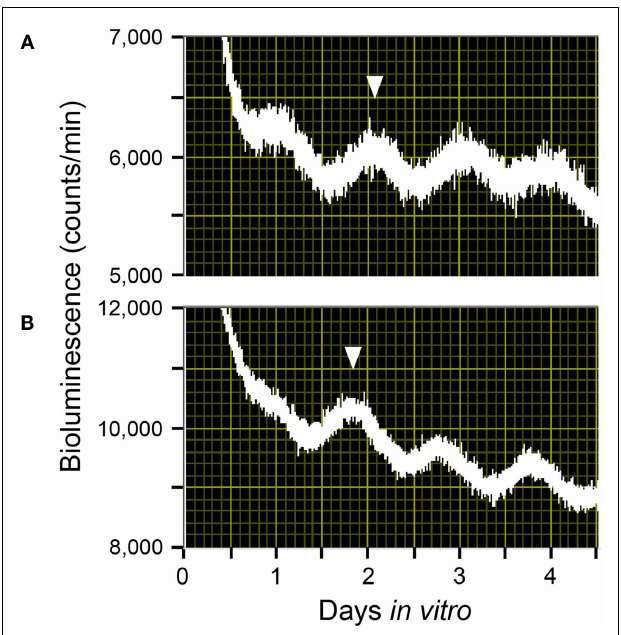
FIGURE 2 | Rhythms of light emission by fetal SCN explants . Shown are raw data from (A) a fetus of an ad lib-fed control Per1::Luc pregnant rat and (B) a fetus of a Per1::Luc pregnant rat that had been exposed to a 4-h restricted-feeding (RF) regimen for 21days after mating.The phase of these peaks is consistent from animal to animal. Here, the phase peak statistically chosen is indicated by the inverted triangles.